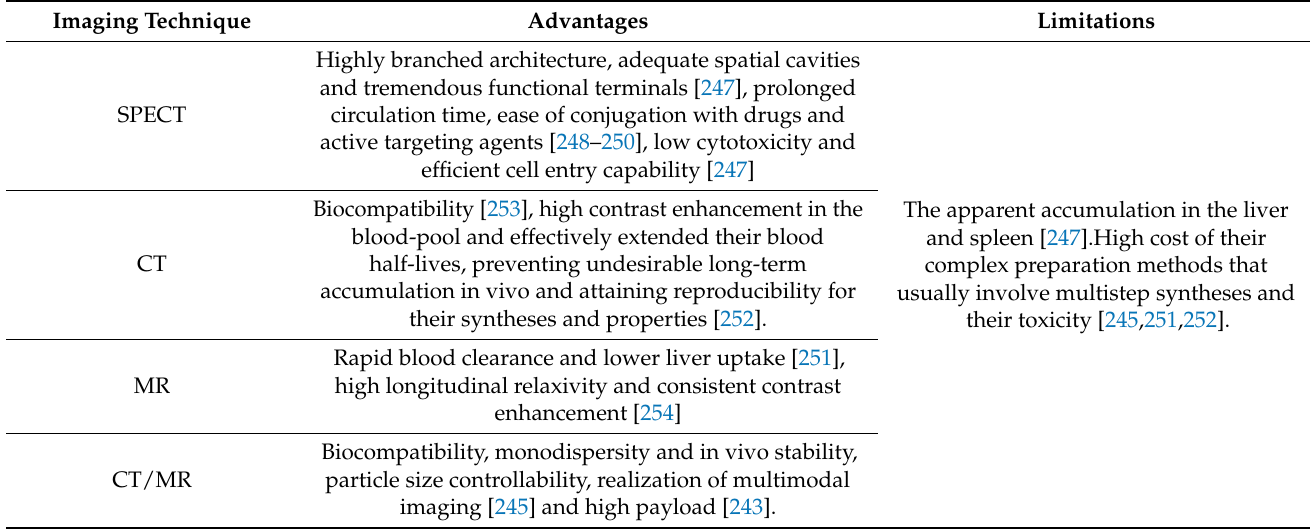
Table 4. Advantages and limitations of dendrimers for imaging purposes.